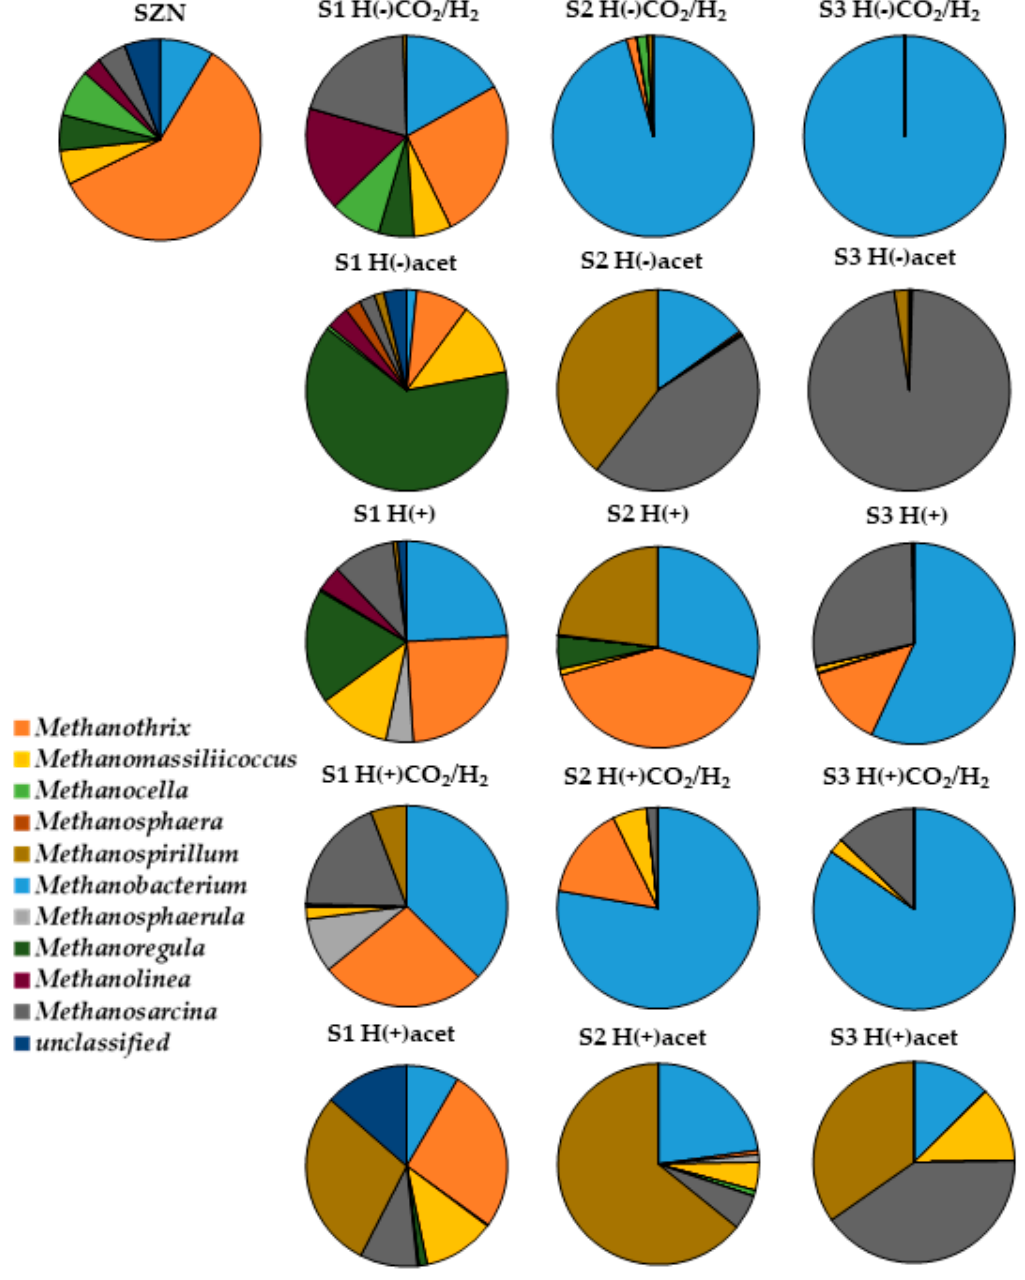
Figure 3. Changes in the methanogen community during incubation in different media.